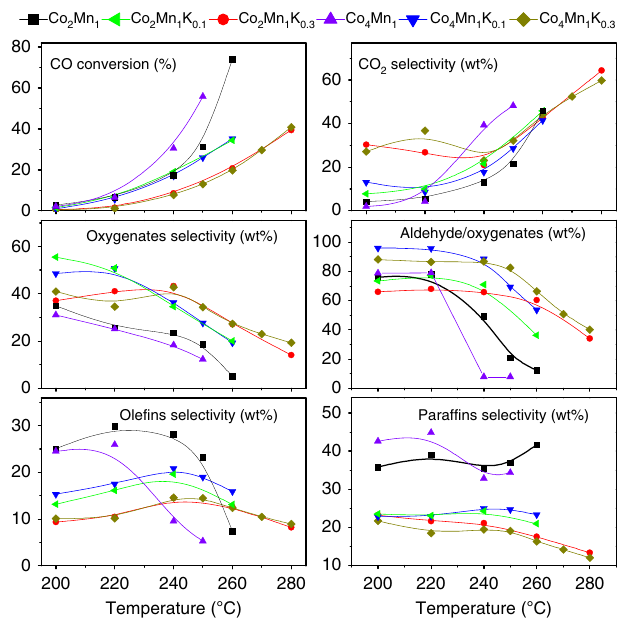
Figure 1 | Catalytic performance. Activity and selectivity of Co 2 Mn 1 K x and Co 4 Mn 1 K x ( x ¼ 0, 0.1 and 0.3) catalysts for CO hydrogenation. Catalytic tests were carried out at P ¼ 40bar, H 2 /CO ¼ 1.5 and total gas flow ¼ 40mlmin (cid:2) 1 . The same batch of catalyst was subjected to conversion at different temperatures (sequential increase from low to high). The catalytic performance of Co 4 Mn 1 K 0.1 at 220 (cid:2) C was reproduced at least five times with errors o 10% over different batches of catalyst. The error for the total carbon balance was B 8% from three different measurements. NATURE COMMUNICATIONS|7:13058|DOI: